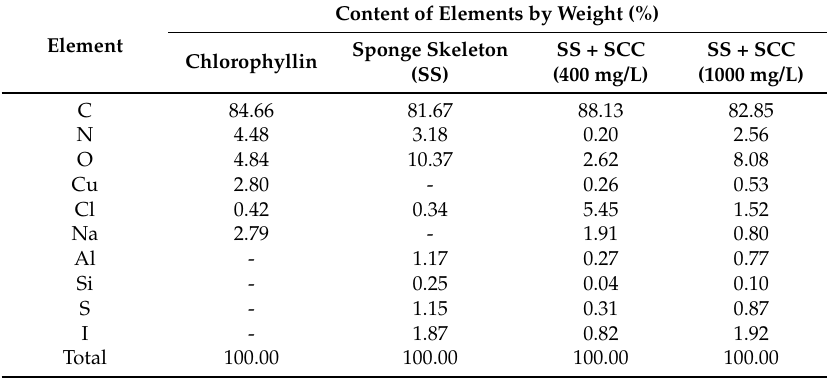
Table 3. EDS analysis results.